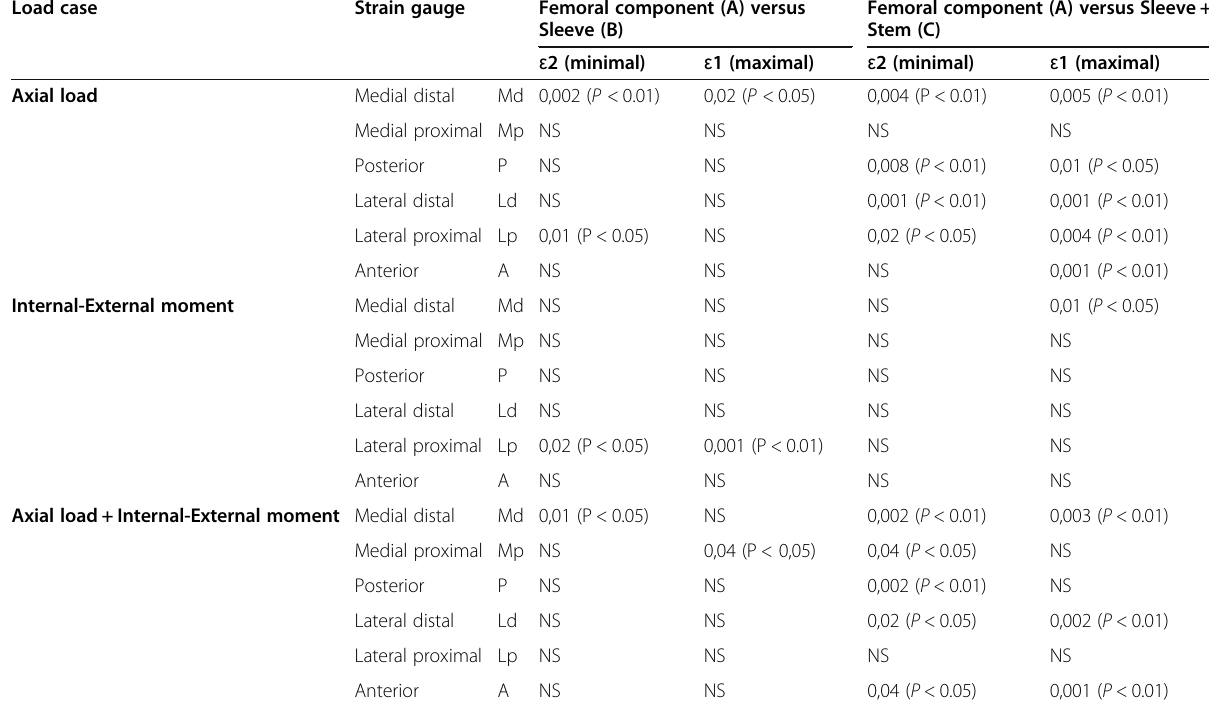
Table 1 P -values obtained from T-tests to test differences between the means of the minimal ( ε 2) and the maximal ( ε 1) principal strains. For a level of significance α , statistically significant differences will be detected when p -value<